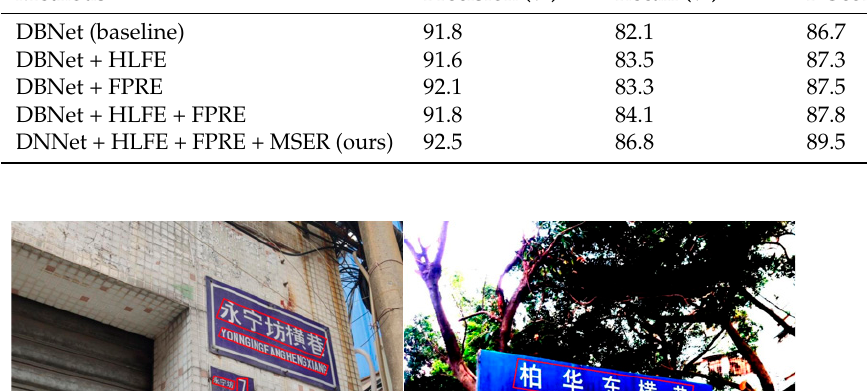
Table 2. Comparison of results of ablation experiments on the NSSS dataset.